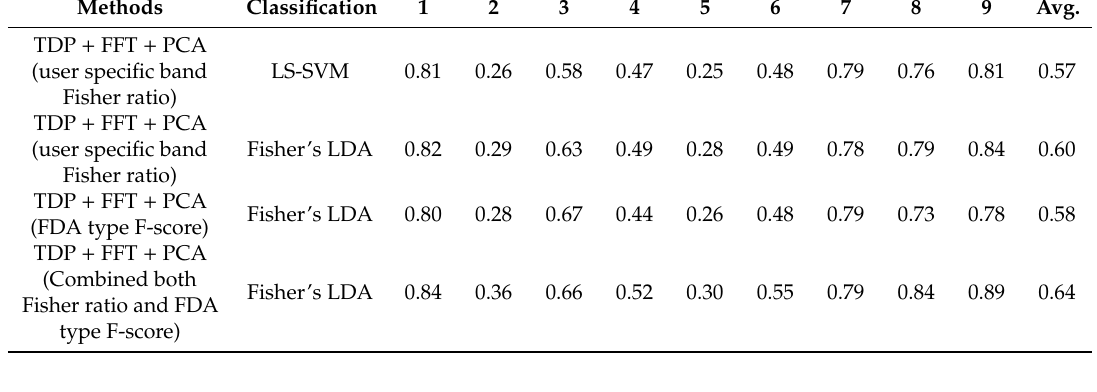
Table 4. Comparison of the proposed method with other combinations.